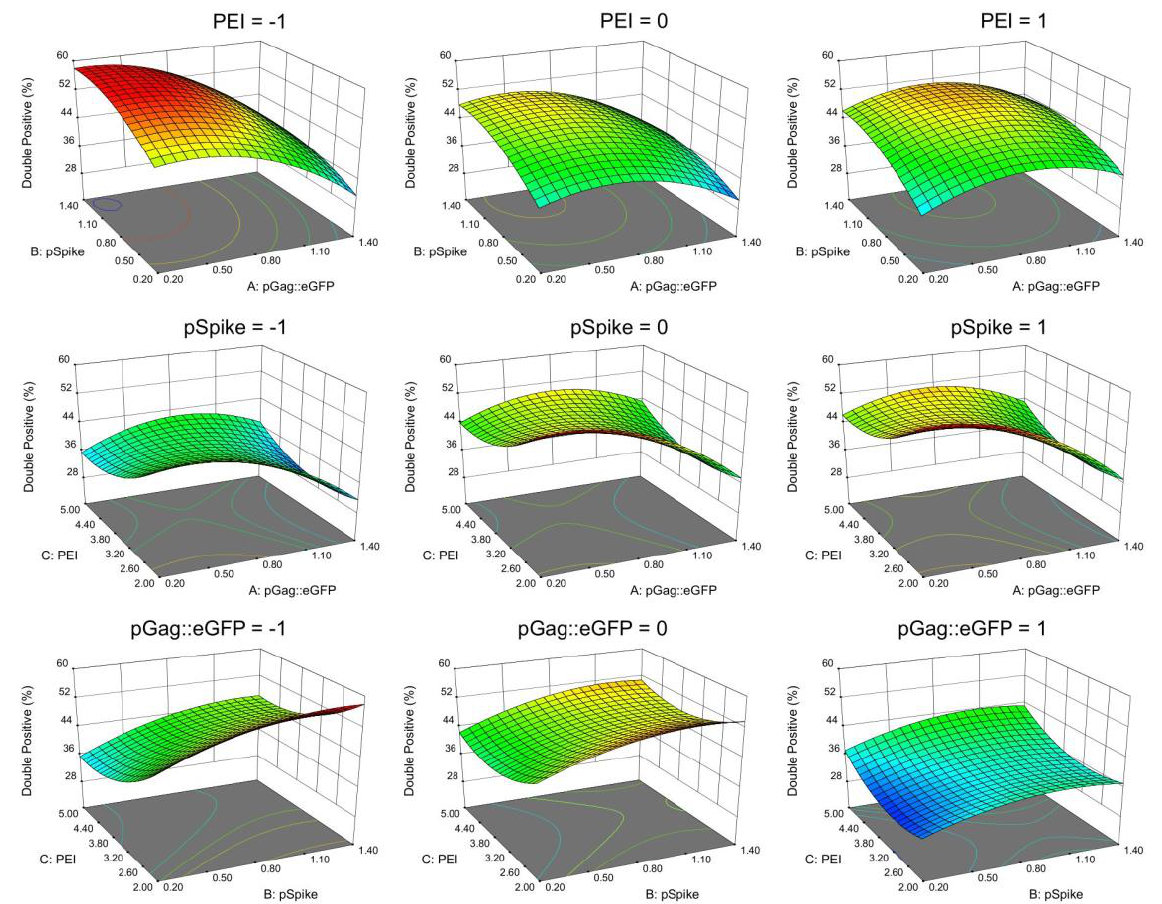
Figure 3. Analysis response surface graphs for the transfection optimization using the Box-Behnken design of experiments. The Y-axis accounts for the analyzed response: the percentage of cells expressing both Gag::eGFP and spike proteins (double-positive population) at 72 h post-transfection. Surface graphs describe the effect of the pGag::eGFP plasmid, pSpike plasmid and PEI concentrations (in µ g/mL) in the double-positive population (% of total cells). Each combination of two independent variables is presented at the X- and Z-axis, while the response is shown at the Y-axis. ( Top ): pSpike vs. pGag::eGFP. ( Middle ): PEI vs. pGag::eGFP. ( Bottom ): PEI vs. pSpike. The third independent variable for each pair is modulated at each of the three coded levels ( − 1, 0, 1), as indicated above each individual surface response